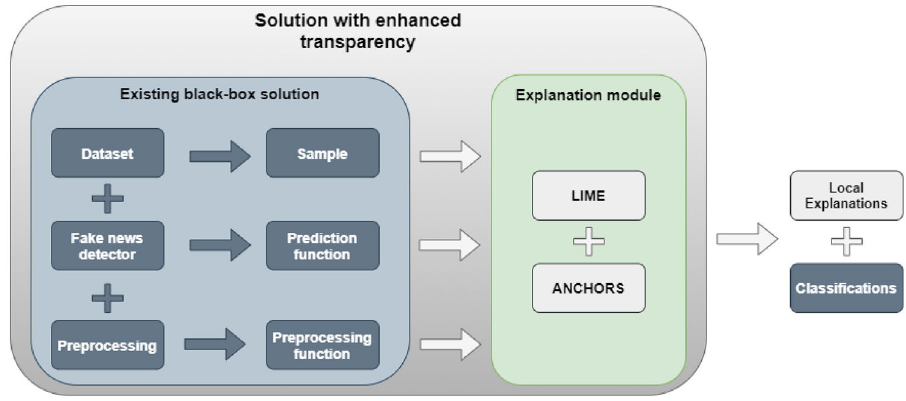
Figure 1. The overview of the proposed